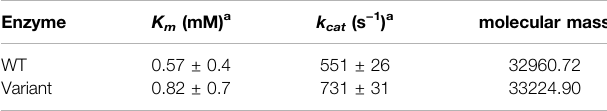
TABLE 2 | Kinetic parameters and molecular masses of wild-type (WT) and Y21pBpF/Y70pBpF/Y114pBpF